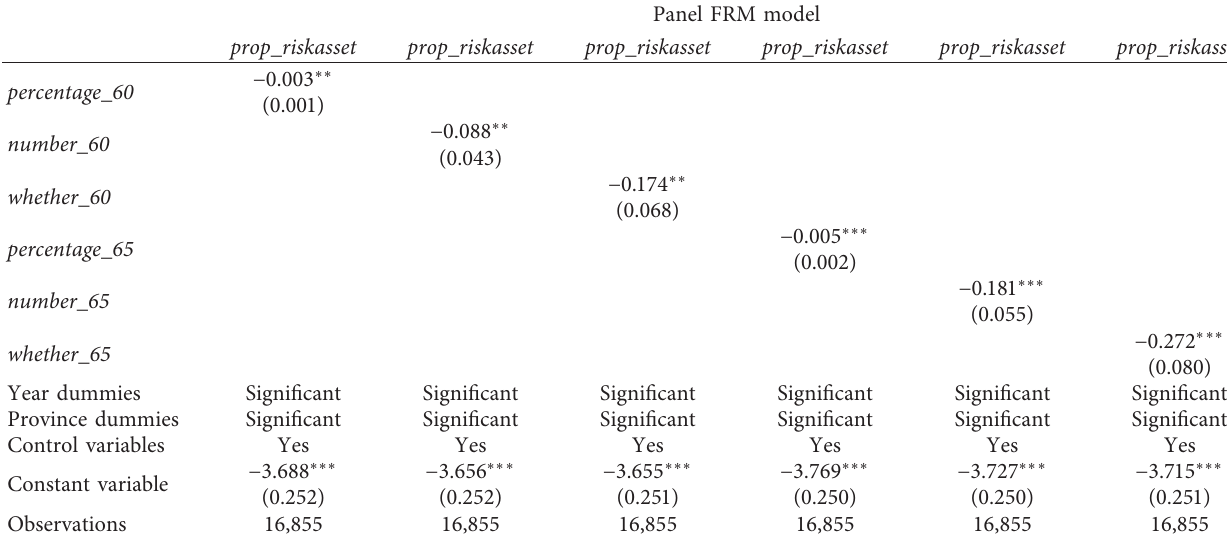
Table 7: Results on the proportion of families’ risk assets investment. Panel FRM model